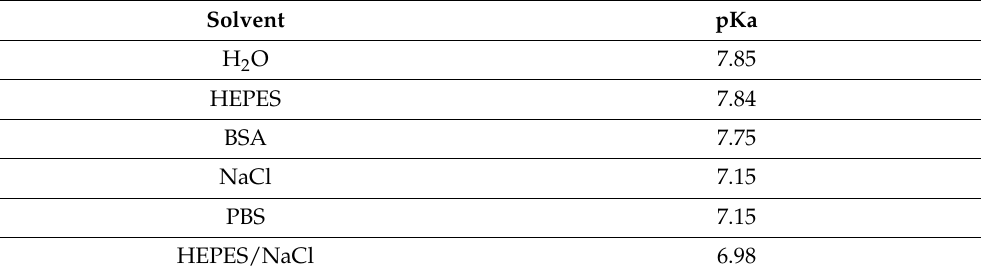
Table 1. Extracted pKa values for HPTS in different